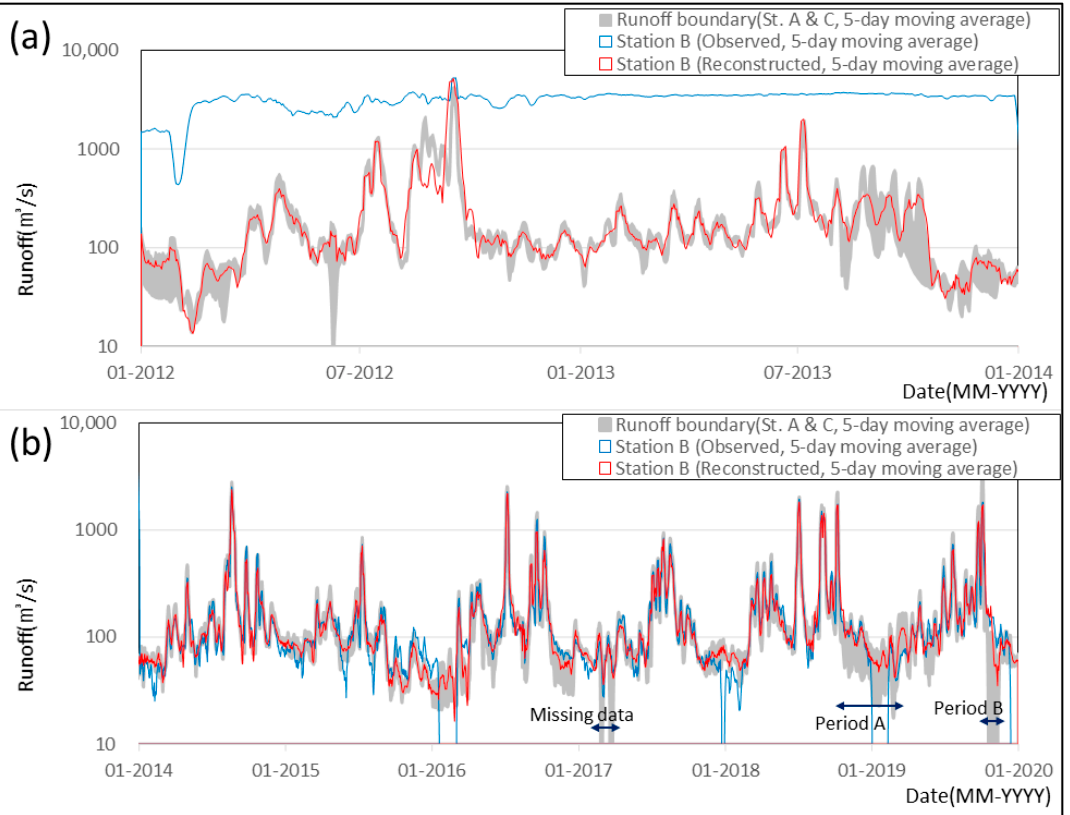
Figure 7. Reconstructed results for station B: ( a ) reconstructed periods, ( b ) observed periods; gray boundary indicates high and low flow at stations A and C, blue line indicates observed runoff, and red line indicates reconstructed (simulated) runoff using the suggested method.